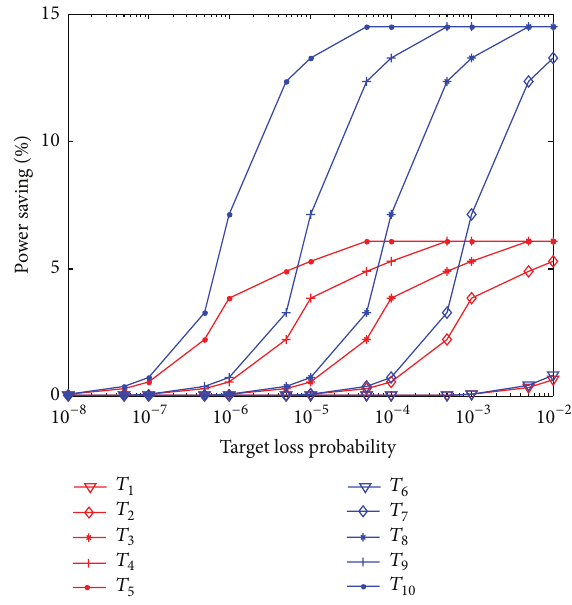
Figure5:MaximumpowersavingduetotheRouterGovernorgiven a maximum loss